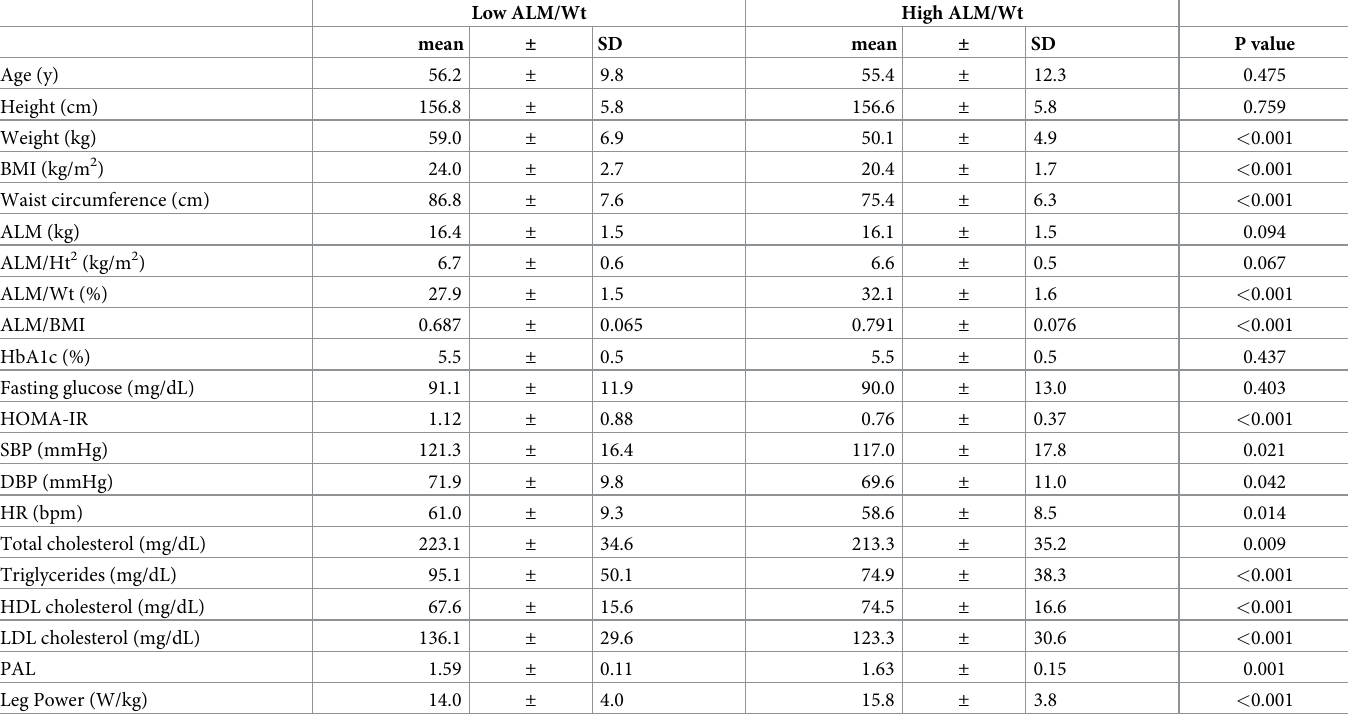
Table 2. Baseline characteristics of the study participants according to relative ALM against body weight (N =